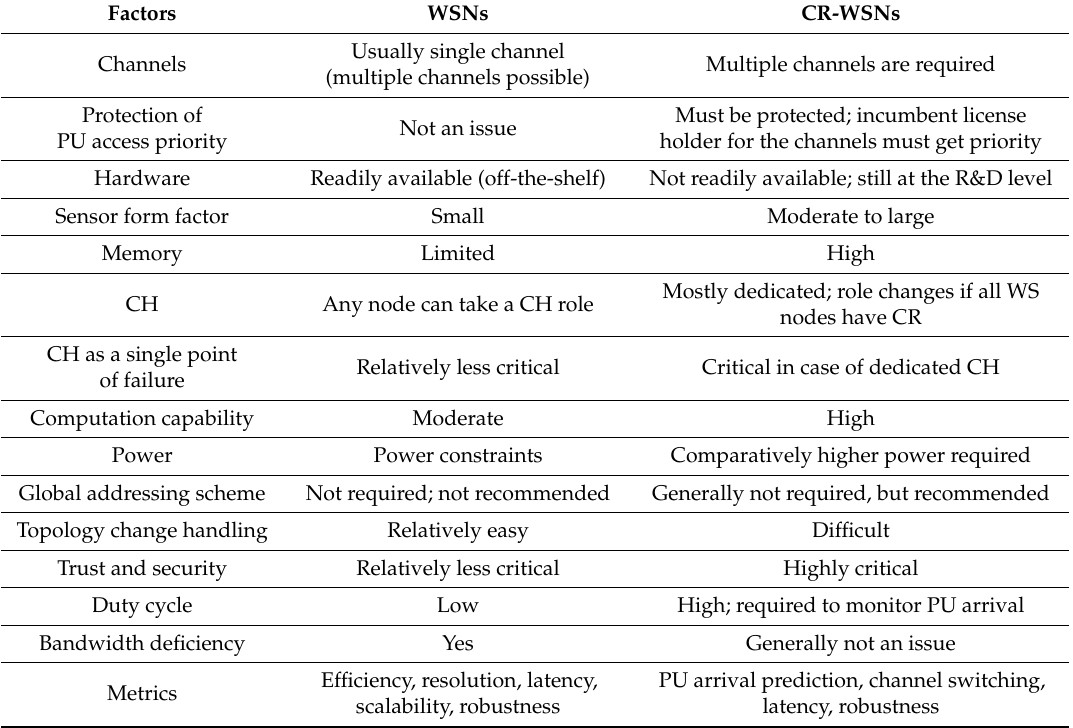
Table 1. Clustering differences between WSNs and